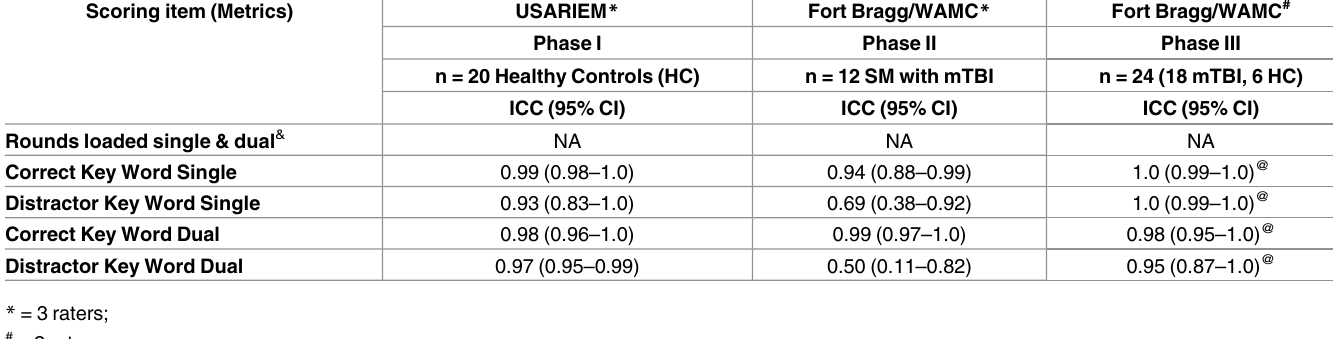
Table 4. Load Magazine-Radio Chatter Interrater Reliability.